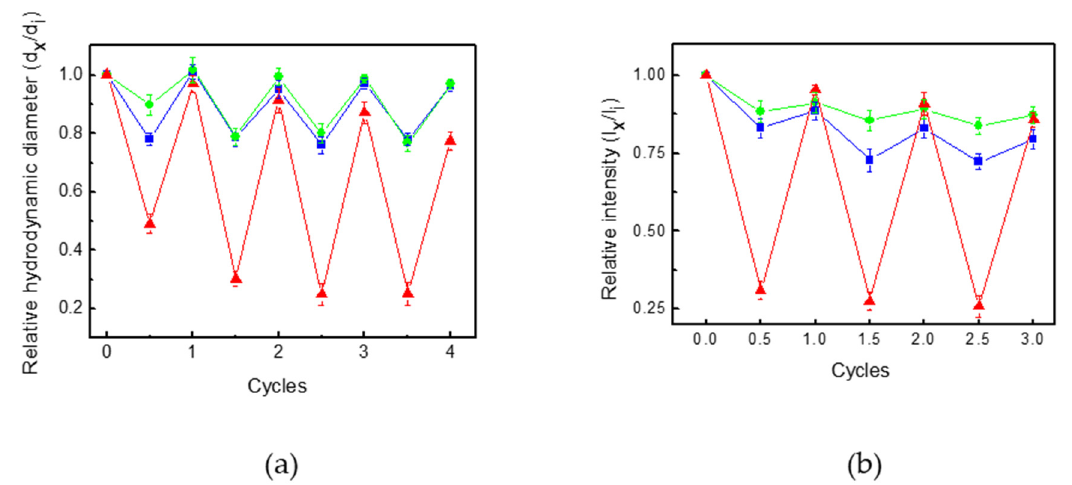
Figure 5. Changes in the ( a ) hydrodynamic diameters and ( b ) relative fluorescence intensities (I x /I i ) of BPdots@PNIPAM ( ■ ), GPdots@PNAIPAM ( ● ), and RPdots@PNAIPAM ( ▲ ) in aqueous solution over repeated heating (45 °C) and cooling (25 ◦ C) cycles. d i and d x correspond to hydrodynamic diameters at 25 ◦ C and at elevated temperatures, respectively. I i and I x correspond to fluorescent intensities (at 415 nm for BPdots@PNAIPAM; 475 nm for GPdots@PNAIPAM; 625 nm for RPdots@PNAIPAM) at 25 ◦ C and at elevated temperature, respectively.